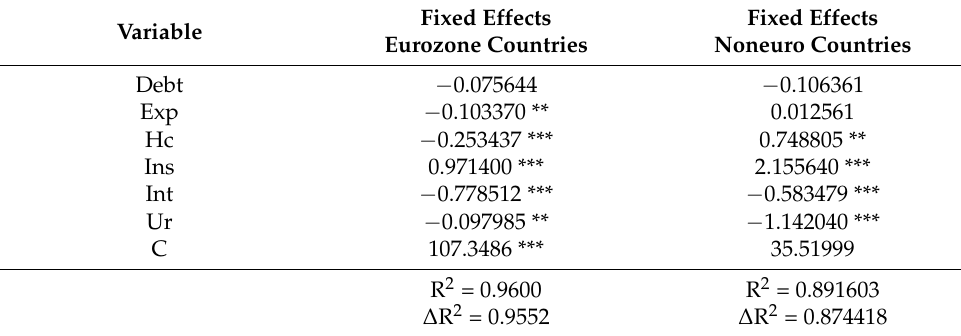
Table 11. The regression model (eurozone countries and noneuro countries).